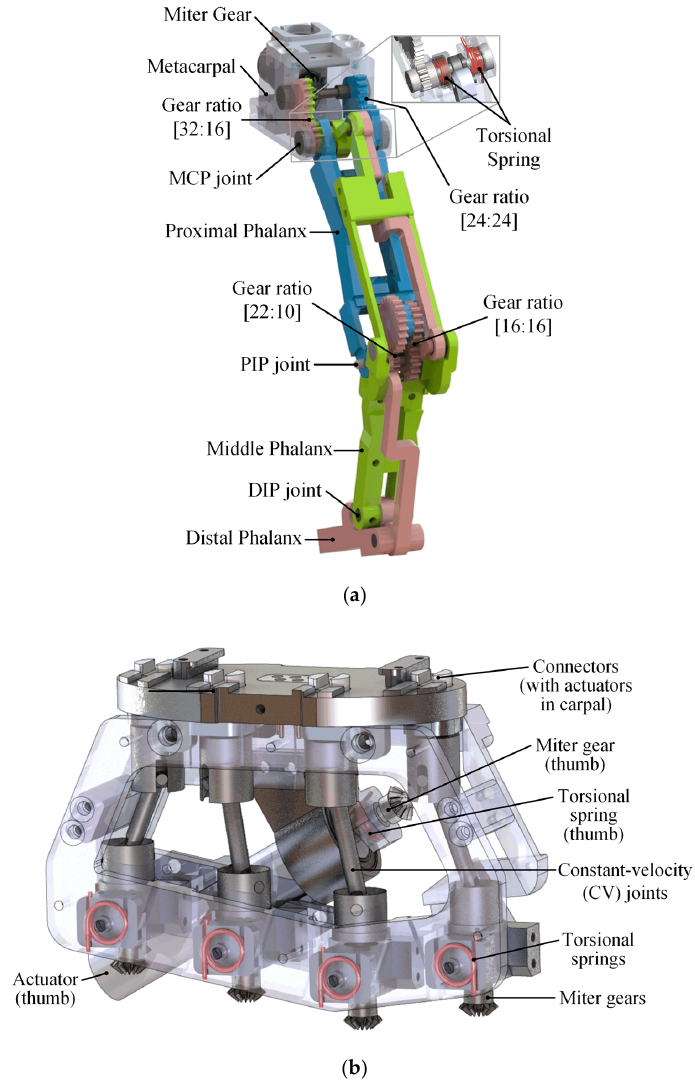
Figure 2. Constitution of ( a ) the finger module and ( b ) palm module. 128